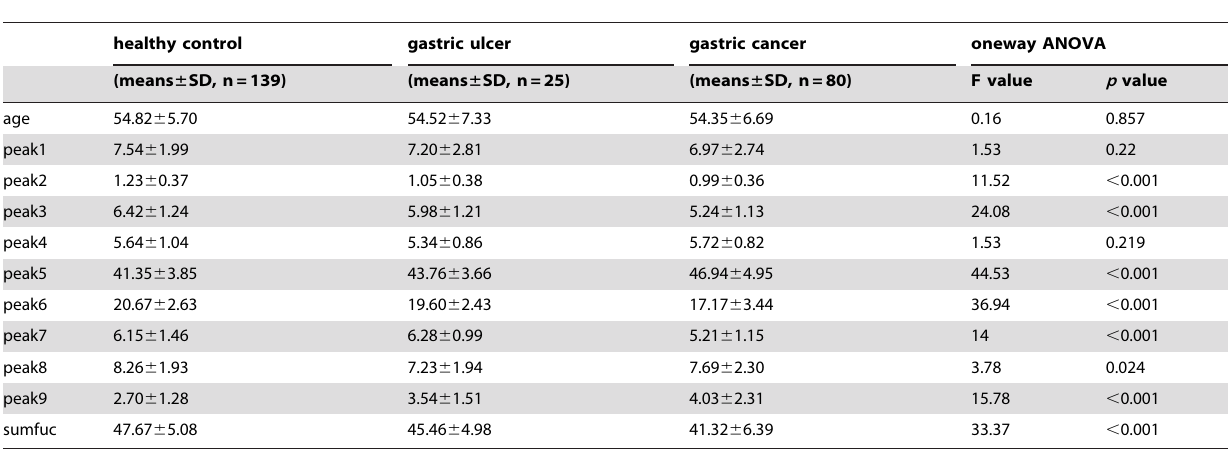
Table 2. General N-glycome profiling results in 3 different